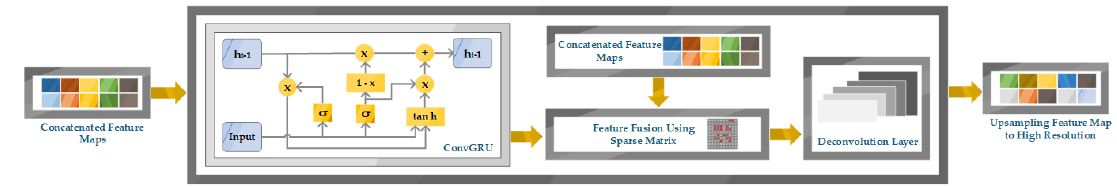
Figure 3. Architecture of the temporal generator.